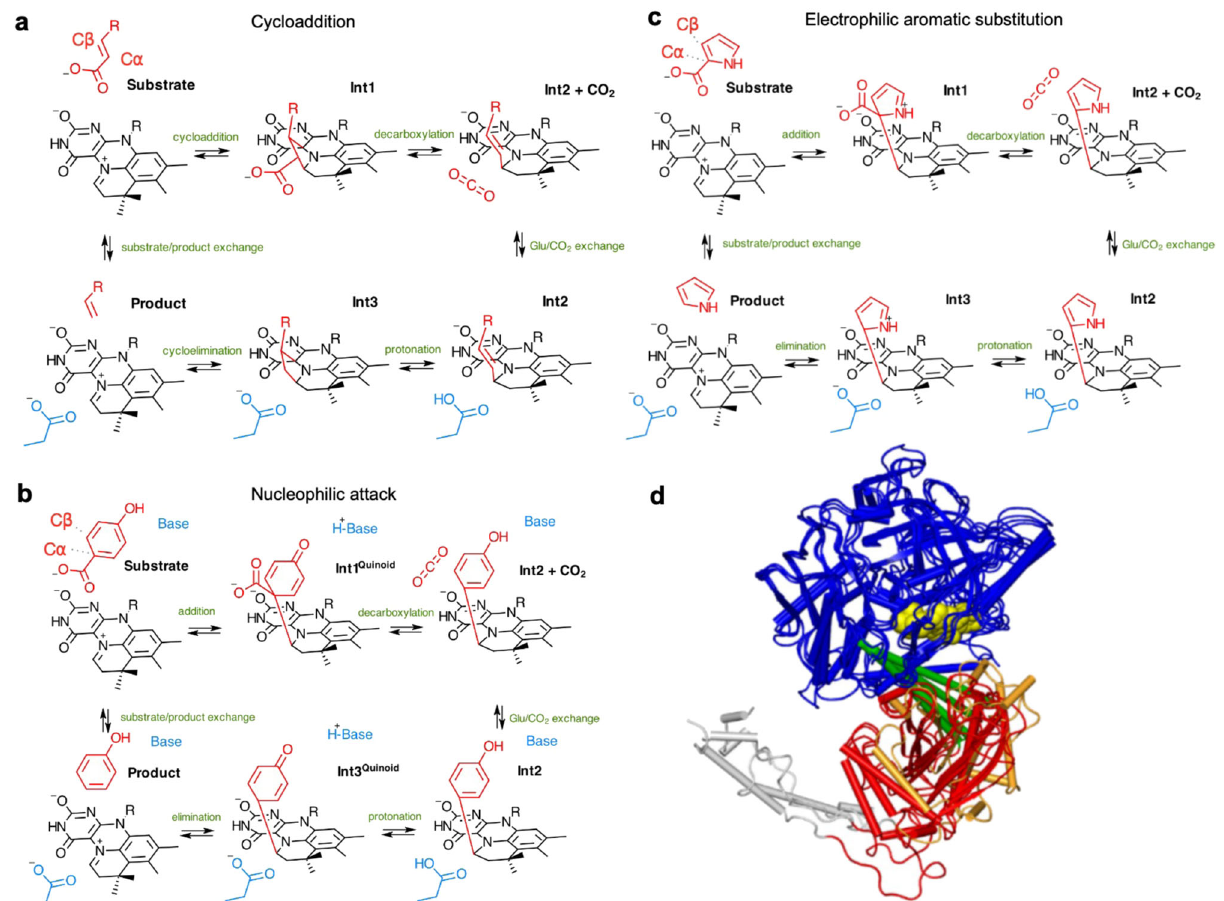
Fig. 1 Mechanism and structures of the UbiD enzyme family. a Proposed 1,3 dipolar cycloaddition Fdc1 mechanism 16,17 . b A substrate nucleophilic attack mechanism proposed for phenolic substrates 18 . c Electrophilic aromatic substitution mechanism postulated for PA0254-mediated decarboxylation of pyrrole-2-carboxylate 19 . All mechanisms share a common Int2 intermediate with an sp 2 hybridized substrate C α . Transient dearomatisation occurring for Int1 and Int3 species presents a signi fi cant energy barrier in each case. prFMN-R = phosphoribityl moiety (omitted for clarity) d Overlay of UbiD monomers anchored on the prFMN binding domain (in blue). The oligomerisation domains of Fdc and PA0254 are shown in orange (representing a closed conformation), while UbiD, HmfF and AroY are shown in open states (in red). The C-terminal helix is shown in grey. The hinge region is located within a helix (in green) connecting the oligomerisation and prFMN binding domains, close to bound cofactor (in yellow